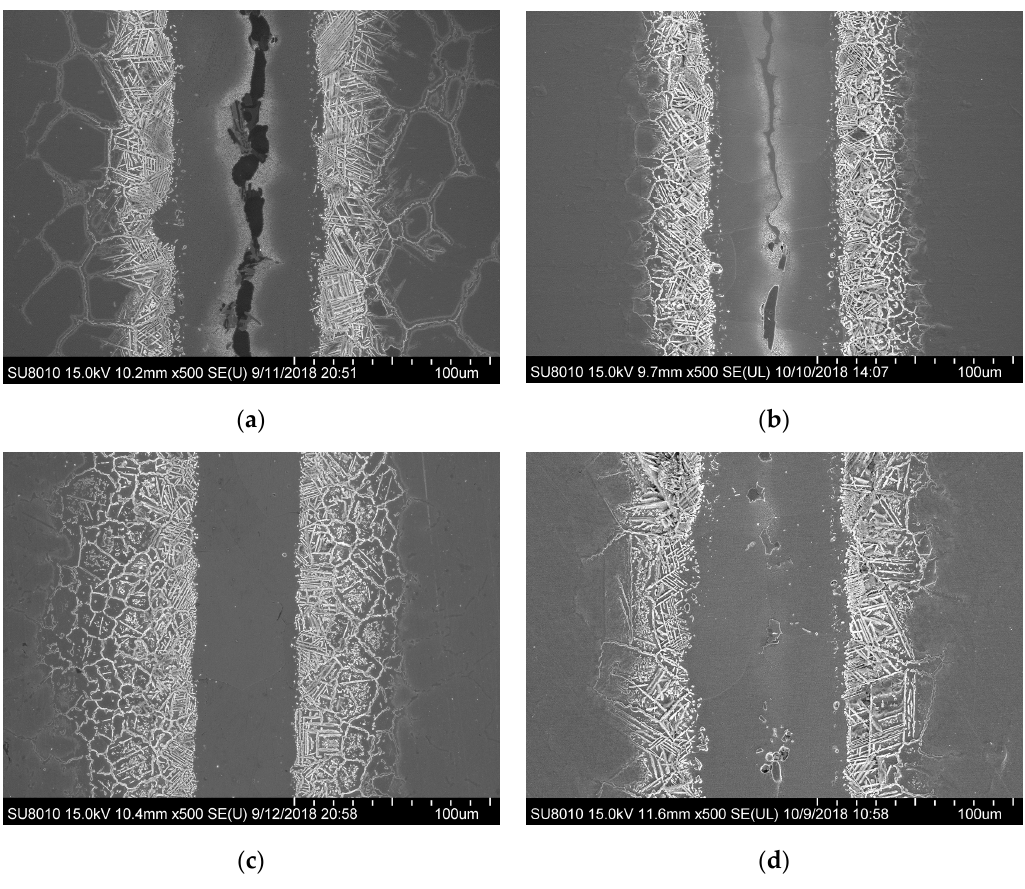
Figure 4. SEM images of TLP-bonded GH4169/BNi-2/GH4169 at different temperatures: ( a ) 1040 °C, ( b ) 1060 °C, ( c ) 1080 °C, and ( d ) 1100 °C.